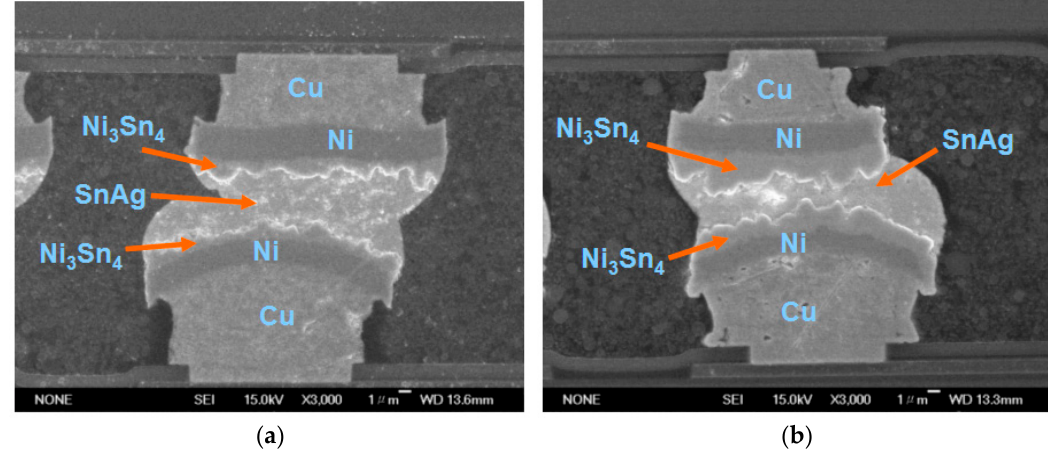
Figure 2. SEM images of the bottom μ -bump array in a four-chip stacking structure generated through four reiterations of the WLUF assembly processes [12]: ( a ) After the bonding of the first chip; ( b ) after the bonding of the fourth chip.